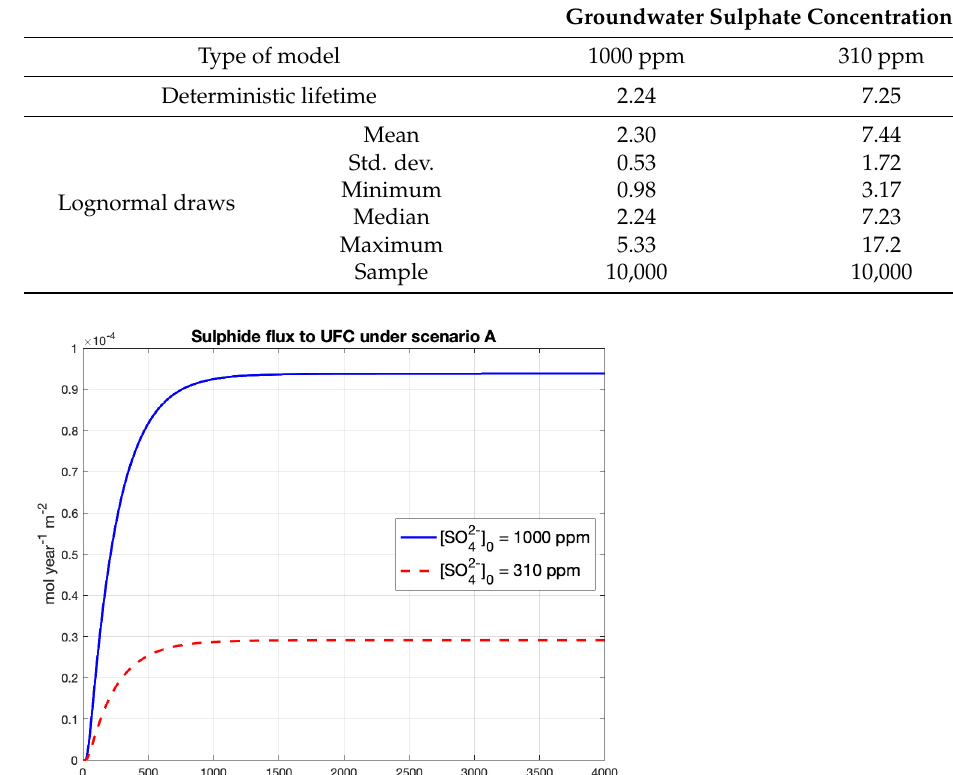
Table 5. UFC lifetimes under scenario A [10 6 years].